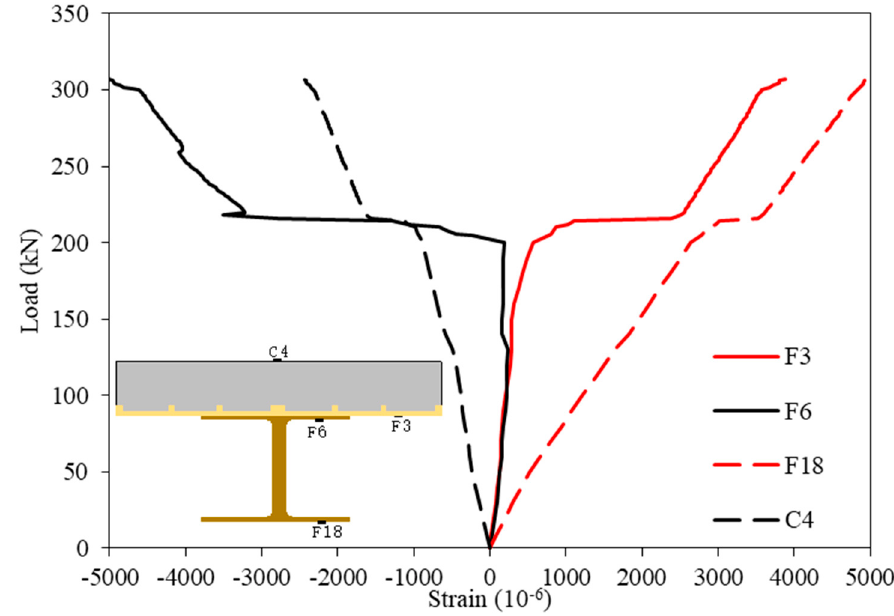
Figure 12. Load versus strain relationship of points along the mid-span section.